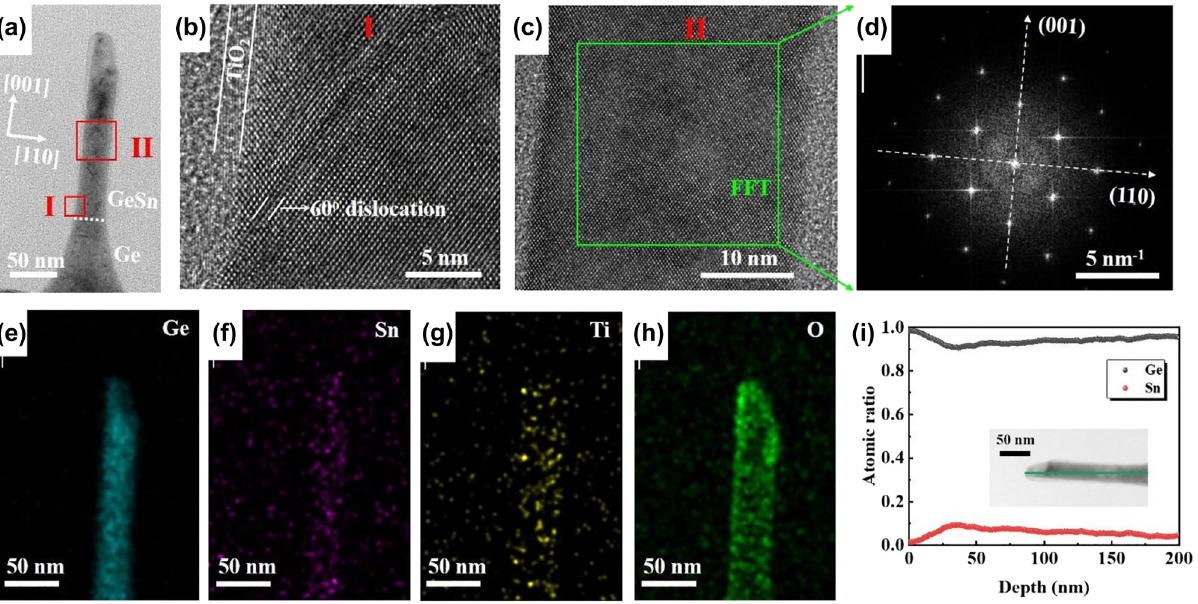
Figure 2: TEM and EDX characterization of a typical GeSn NW. (a) Cross-section TEM image of a GeSn vertical NW coated with 4 nm TiO images of (b) region I and (c) region II in Figure 2(a). (d) FFT of the GeSn NW region in the green square of Figure 2(c). EDX area scans of (e) Ge, (f) Sn, (g) Ti, and (h) O elements of the vertical GeSn NW. (i) Sn and Ge depth profiles of the GeSn vertical NW taken from EDX line scan.